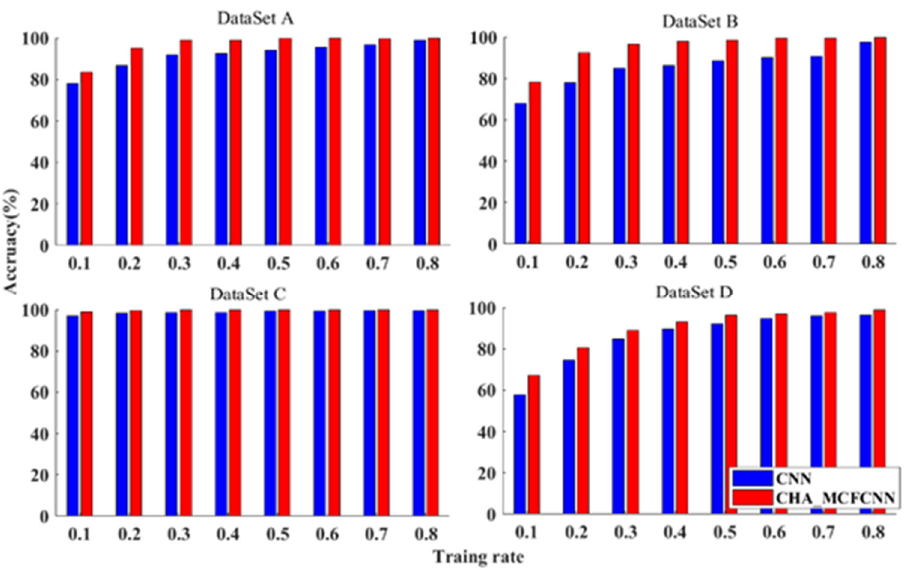
Figure 9. The average diagnostic results of single channel CNN and CAM_MCFCNN model on the test sets under limited training sample conditions.